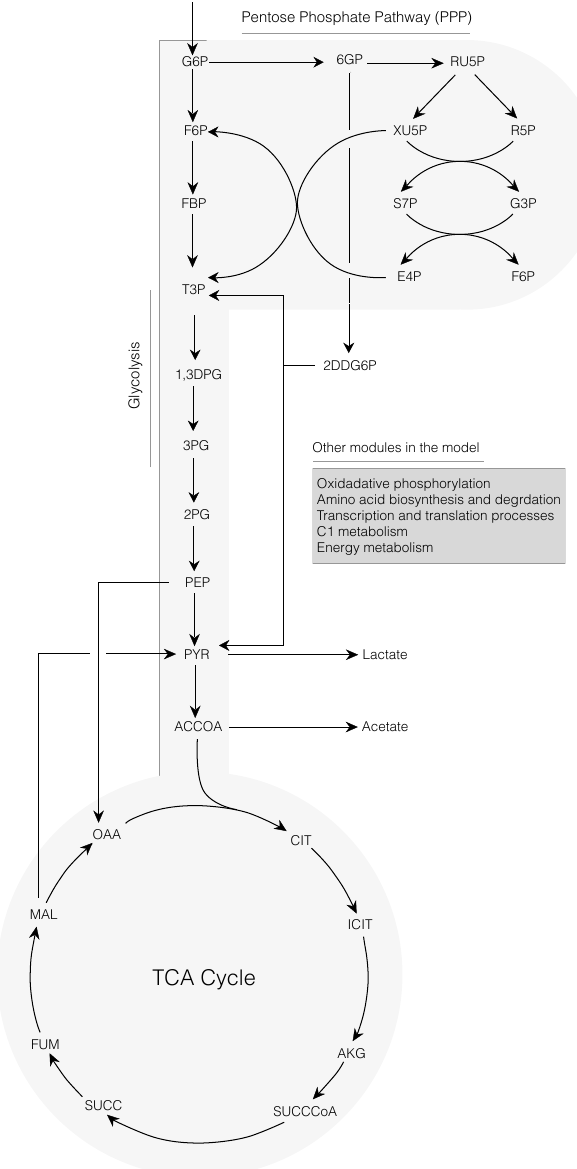
Figure 1. Schematic of the core portion of the cell-free E. coli metabolic network. The network consisted of 264 reactions and 146 metabolites. Metabolites of glycolysis, pentose phosphate pathway, Entner-Doudoroff pathway, and the tricarboxylic acid (TCA) cycle are shown. Metabolites of oxidative phosphorylation, amino acid biosynthesis and degradation, transcription/translation, chorismate metabolism, and energy metabolism are not